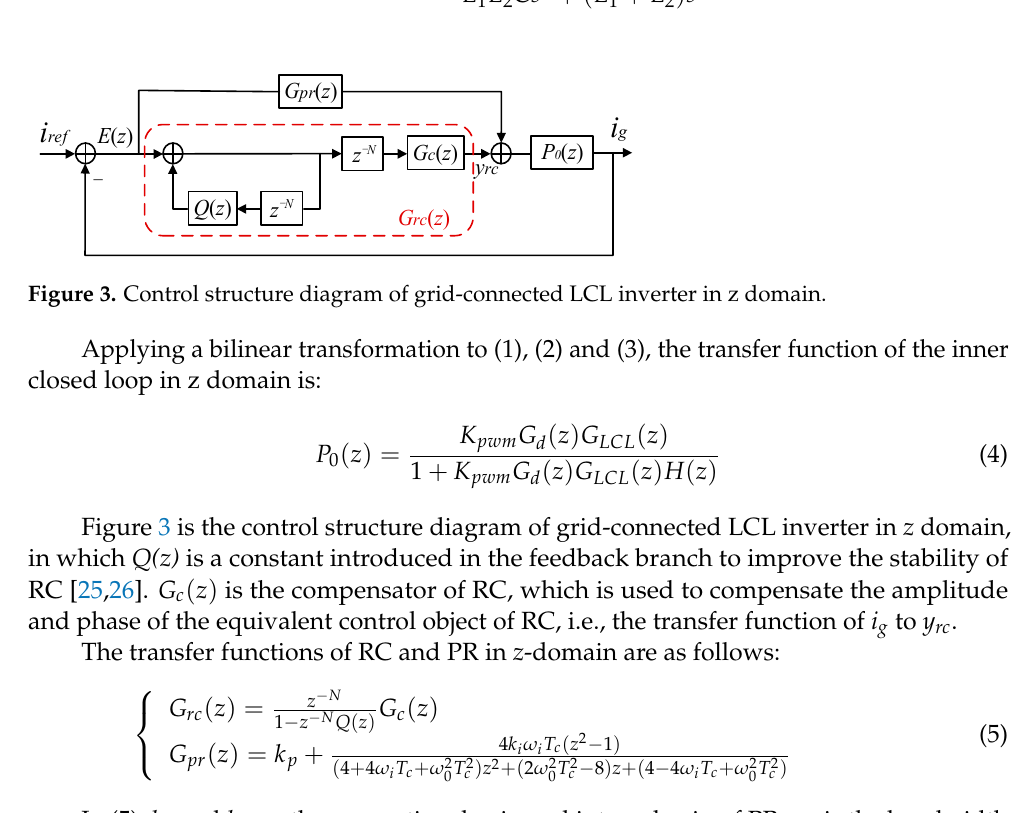
Figure 3. Control structure diagram of grid ‐ connected LCL inverter in z domain.